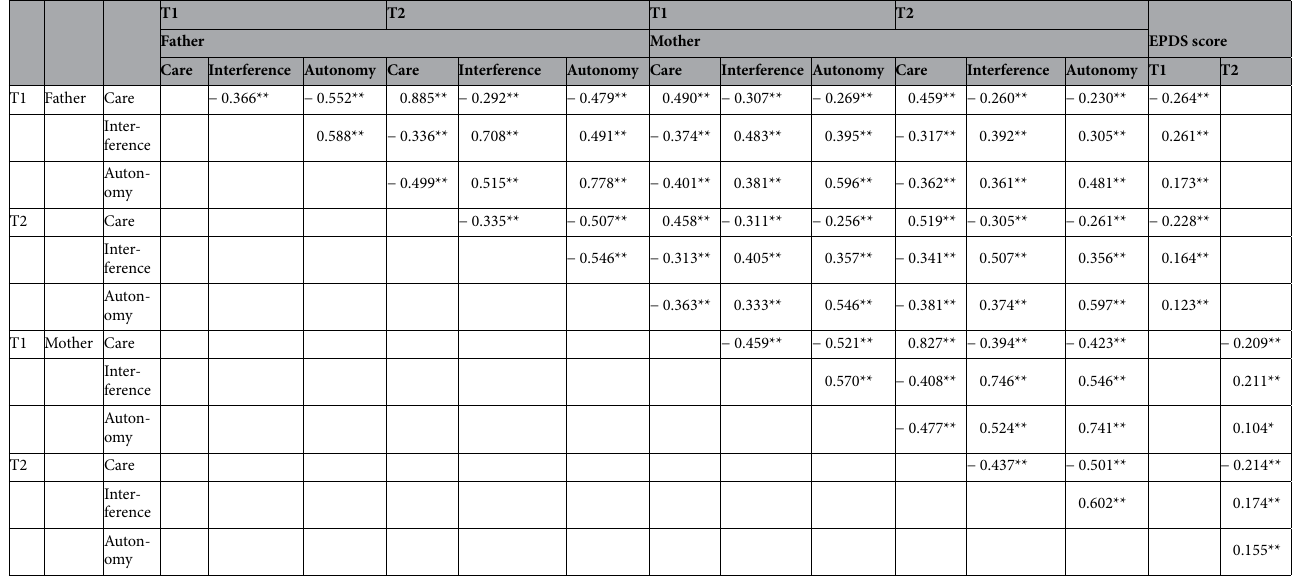
Table 6. Spearman’s correlation coefficients of the Parental Bonding Instrument subscale scores and the Edinburgh Postnatal Depression Scale, n = 466. PBI: Parental Bonding Instrument; EPDS: Edinburgh Postnatal Depression Scale, T1: at early pregnancy before week 25; T2: at 1 month postpartum. * p < 0.05; ** p <